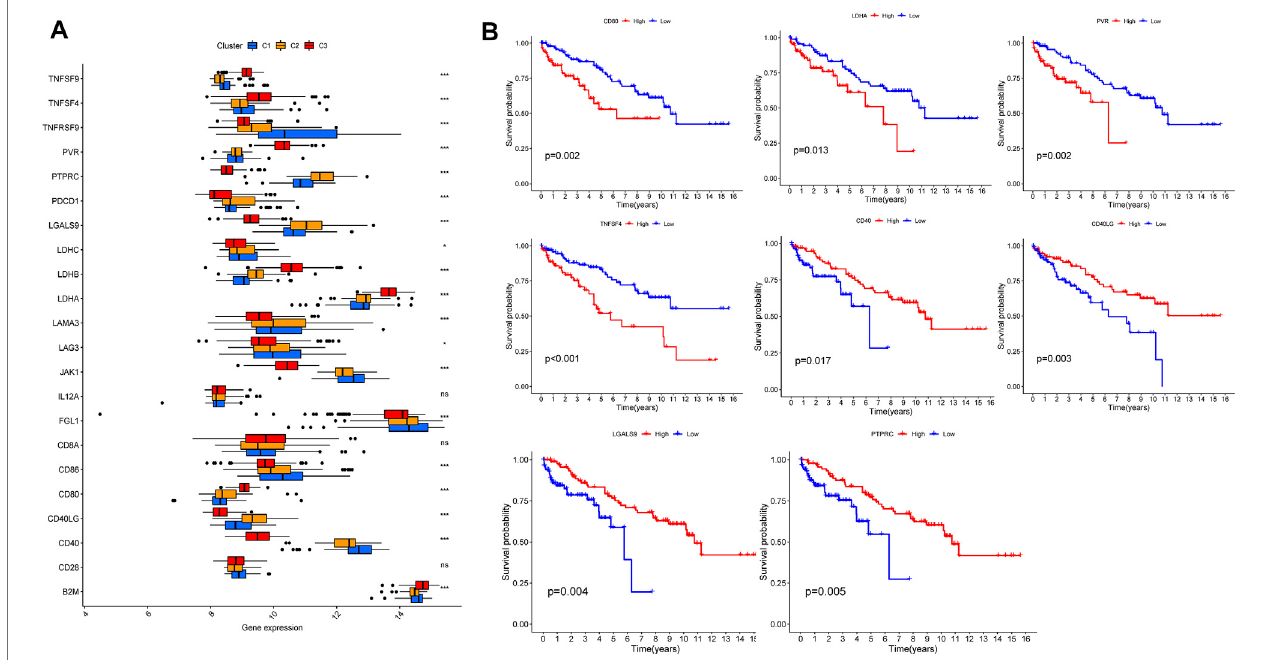
FIGURE6| ICGsexpressionacrossthreeHCCclustersandprognosticanalysis (A) .Differentialexpressionanalysisof35ICGs (B) .Kaplan-MeieranalysisofCD80, LDHA, PVR, TNFSF4, CD40, CD40LG, LGALS9, and PTPRC.